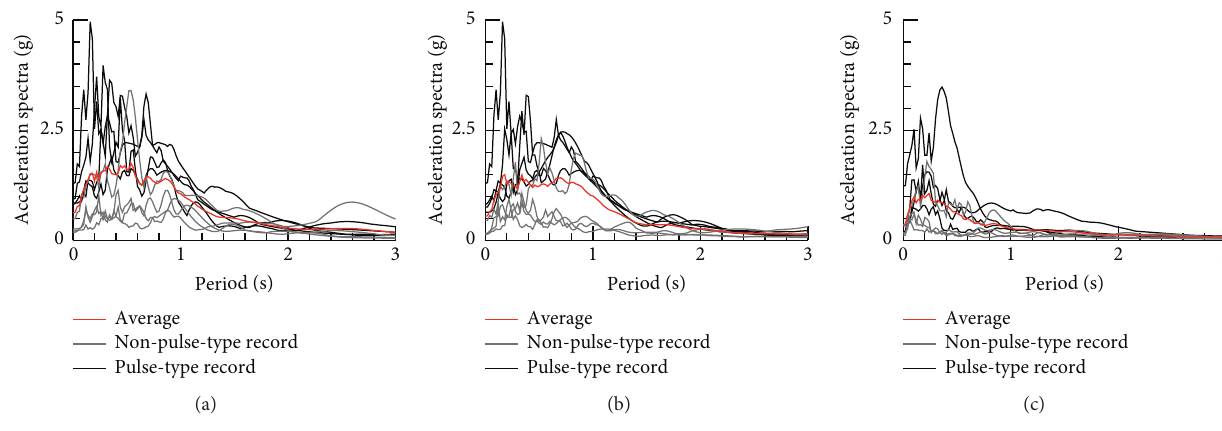
Figure 6: Response spectra of strong component, weak component, and vertical component of the selected records. (a) Strong component. (b) Weak component. (c) Vertical component.